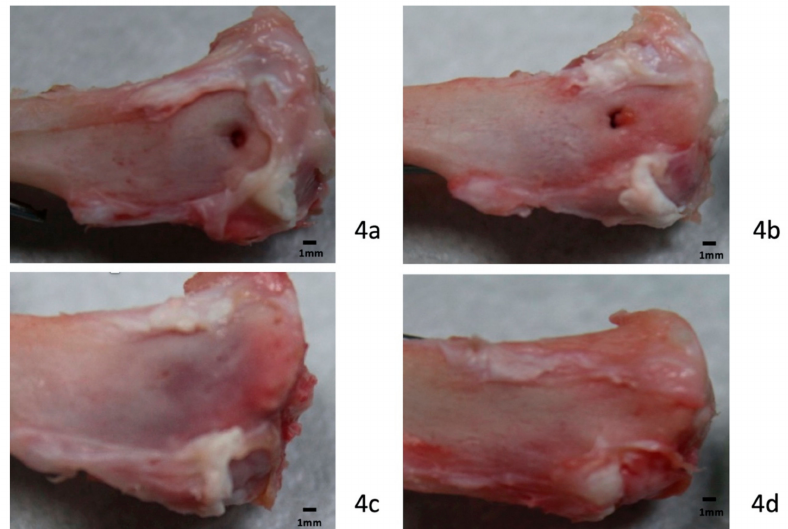
Figure 4. Necropsy examination. Photography at necropsy showed bone-tunnel healing in a rabbit model. A bony defect was identified in the control group at 4 weeks ( a ) and 8 weeks ( b ). Better bony ingrowth with a decrease in tunnel diameter was seen in the study group at 4 weeks ( c ) and 8 weeks ( d ) (scale bar: 1 mm).